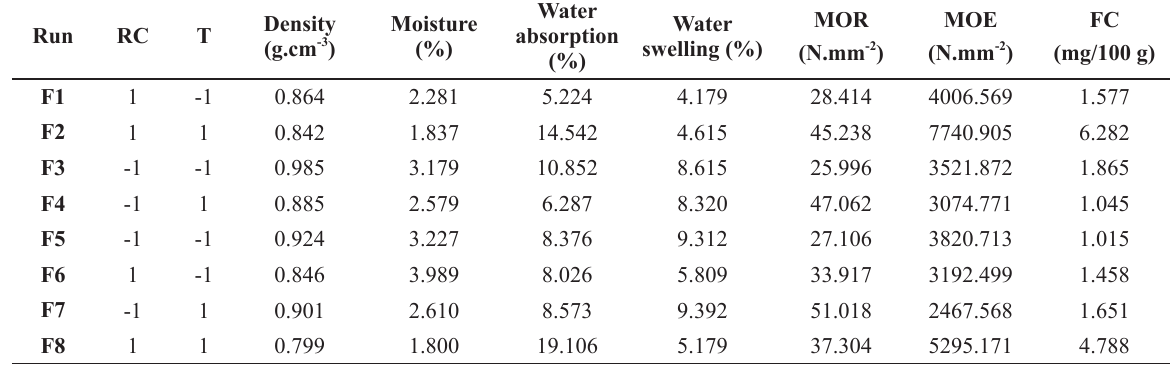
Experimental design layout and mechanical, physical and chemical properties of fiber boards.